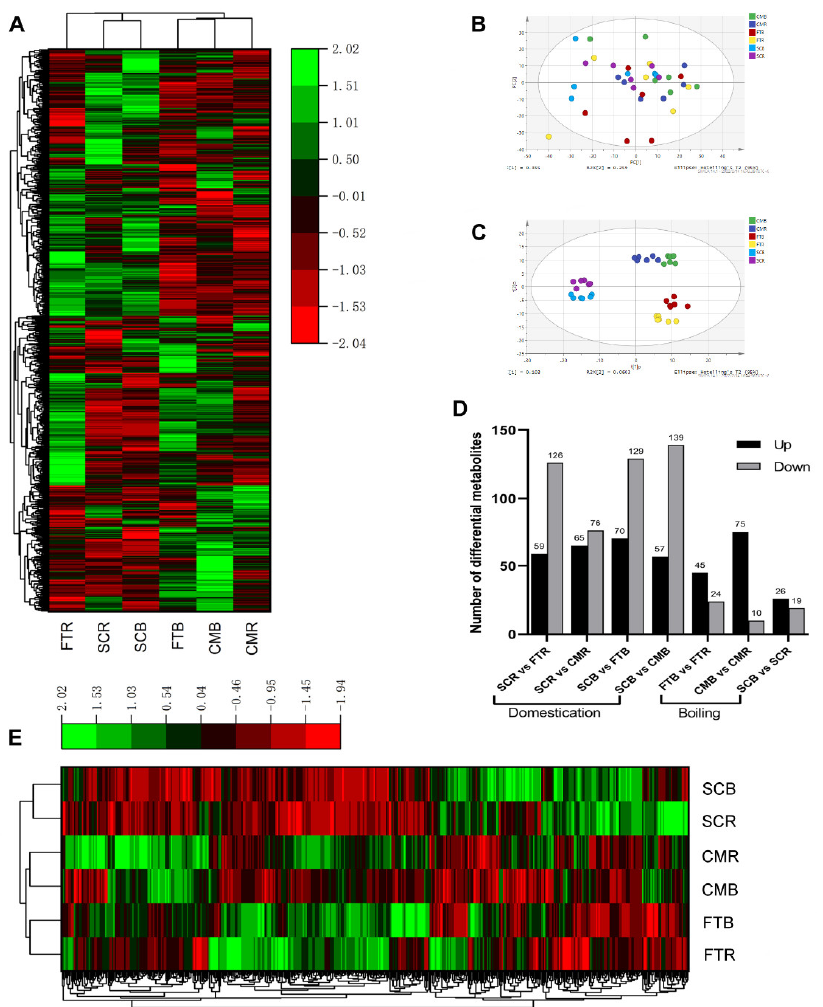
Figure 1. Metabolic profiles of yolk samples from six groups of duck eggs. ( A ) Heatmap of all identified metabolites. ( B ) Principal component analysis (PCA) score plots for all samples. ( C ) Orthogonal partial-least-squares discriminant analysis (OPLS-DA) score plots of the metabolomic data from six groups. ( D ) The number of differential metabolites in pairwise comparisons. ( E ) Hierarchical cluster analysis (HCA) of the differential metabolites identified in seven pairwise comparisons based on the normalized average abundance of the metabolomic profiles.